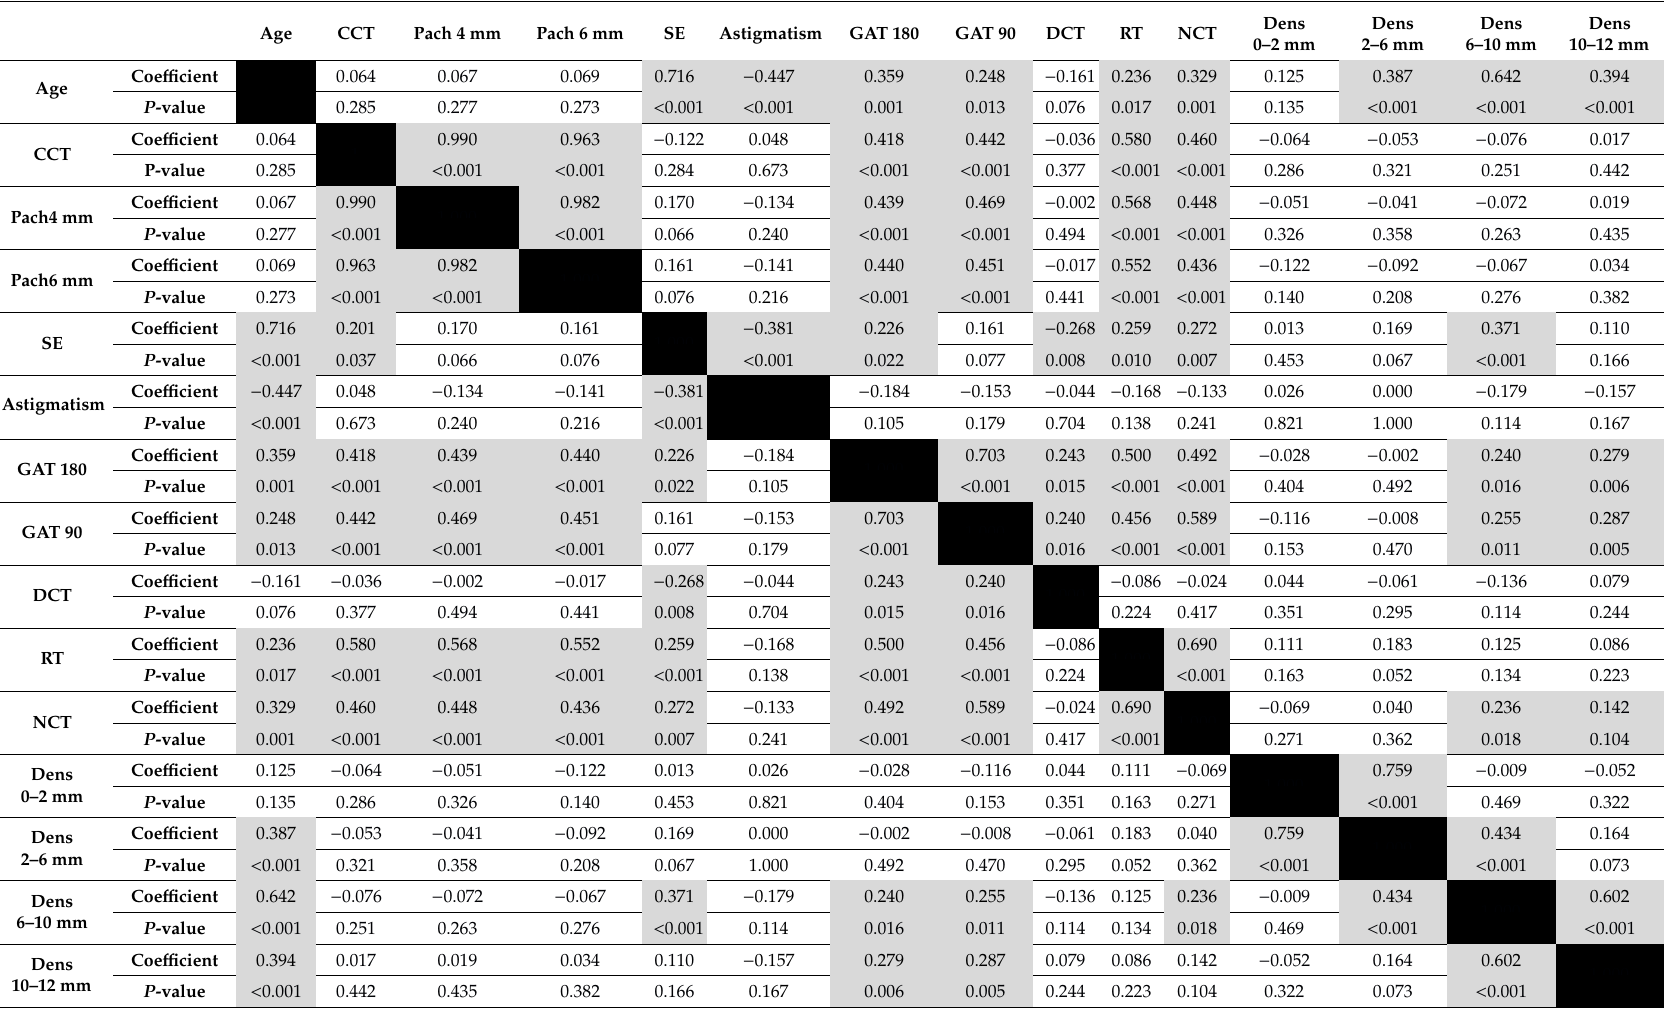
Table 3. Correlation between IOP measurements using GAT, DCT, RT and NCT, and corneal properties including corneal thickness (central, 4 mm and 6 mm) and corneal densitometry (0–2, 2–6, 6–10 and 10–12